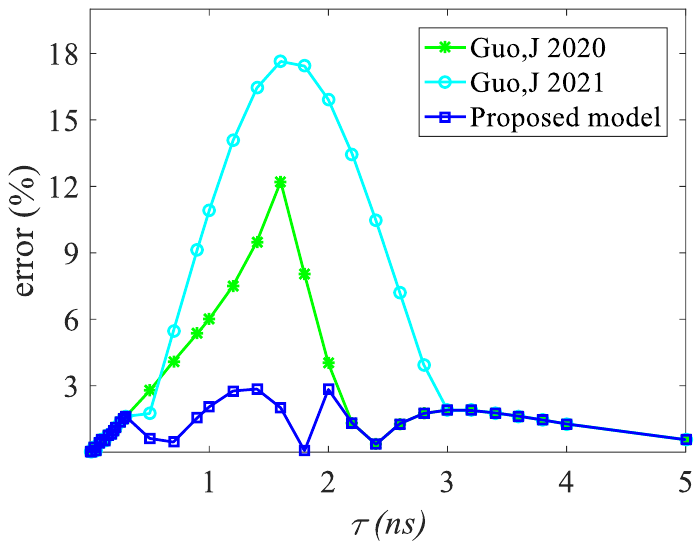
Figure 6. Verification results of the proposed and competitive models [7,8] compared with MC SPICE simulation results. ( a ) inverter gate with 5 fF load; ( b ) NAND gate with 5 fF load ( c ) NOR gate with 5 fF load. ( d ) inverter gate with 10 fF load; ( e ) NAND gate with 10 fF load ( f ) NOR gate with 10 fF load.